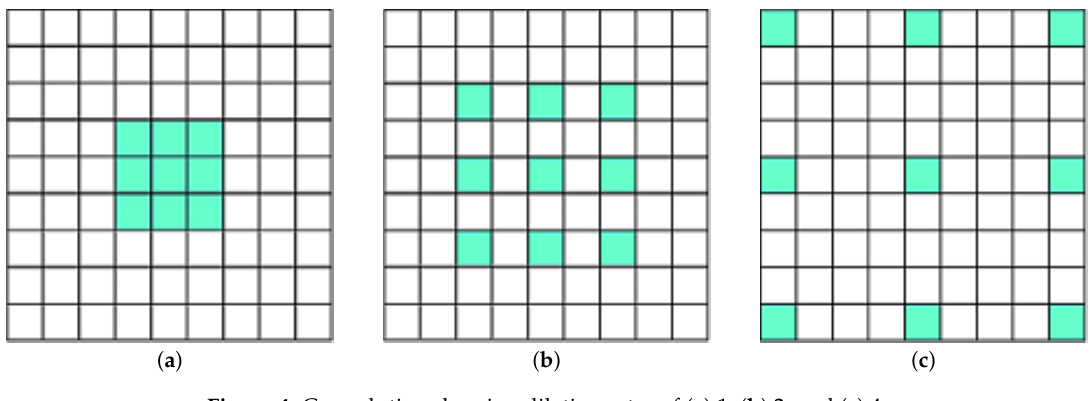
Figure 4. Convolution showing dilation rates of ( a ) 1, ( b ) 2, and ( c ) 4.